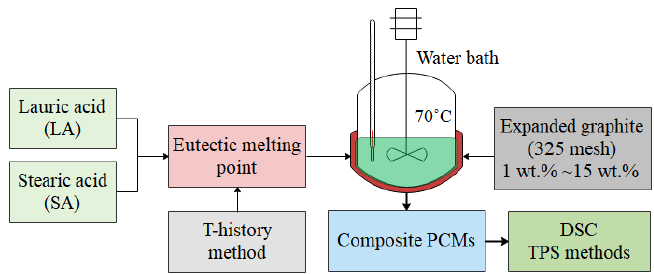
Figure 2. The preparation process of composite PCMs.